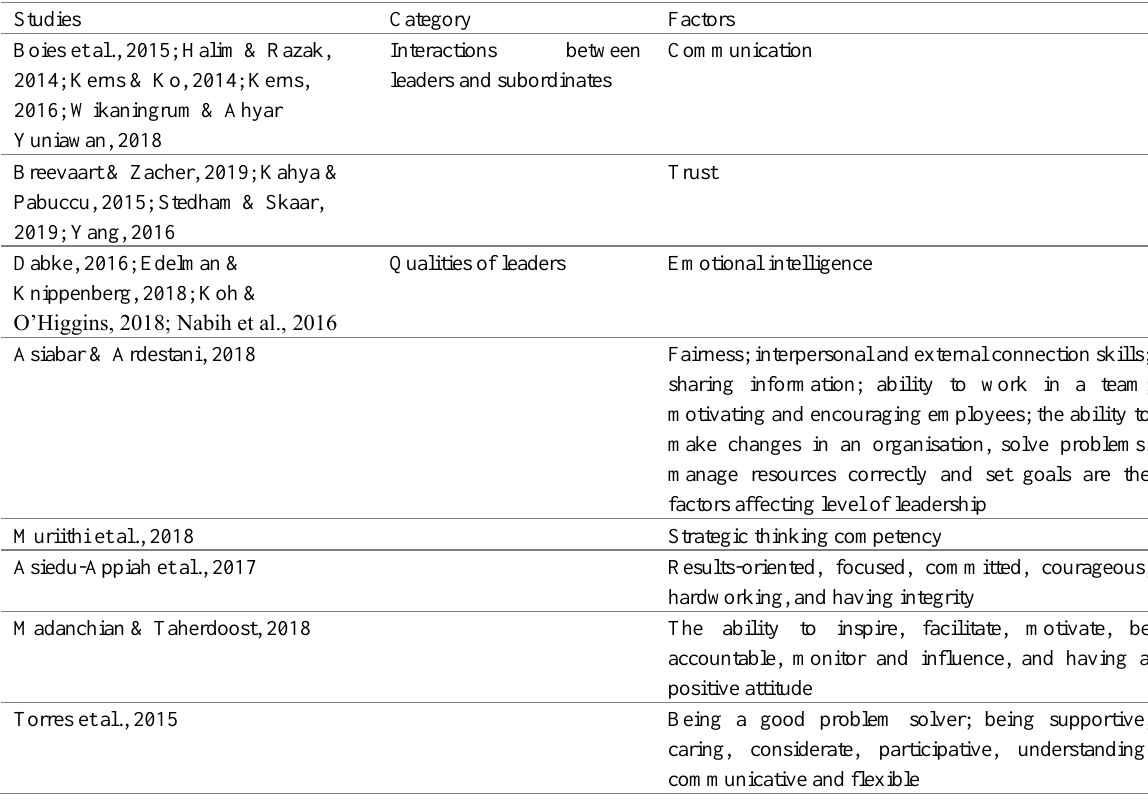
Table 2: Factors Affecting Level of Leadership as Identified in Previous